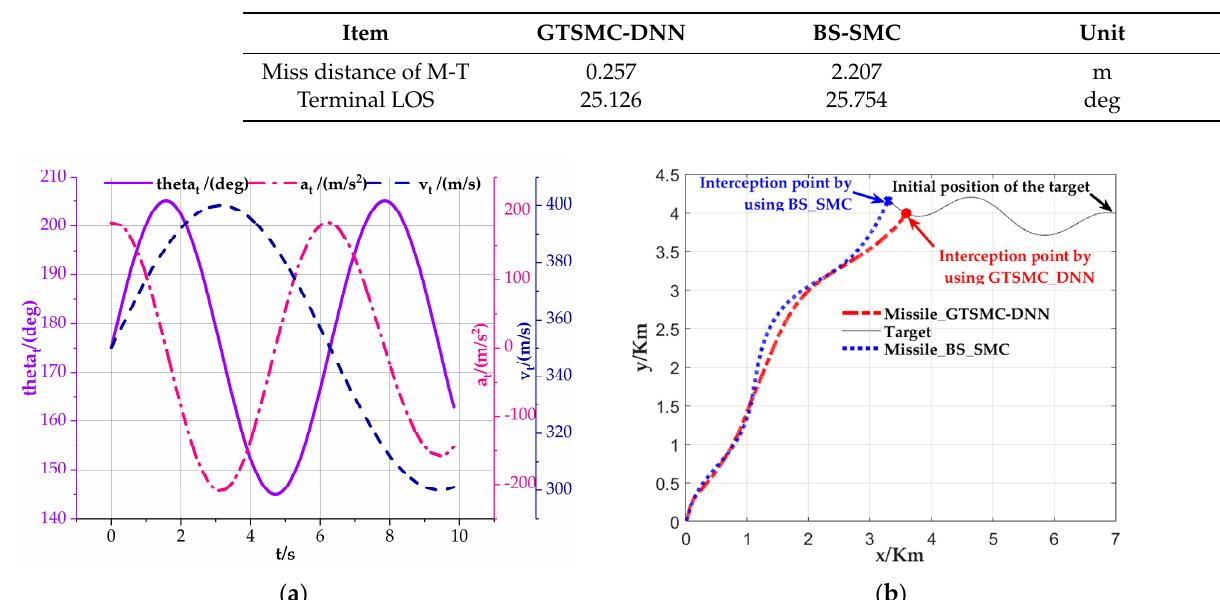
Figure 9. ( a ) The maneuver characteristics of the target; ( b ) The missile-target pursuit trajectory.